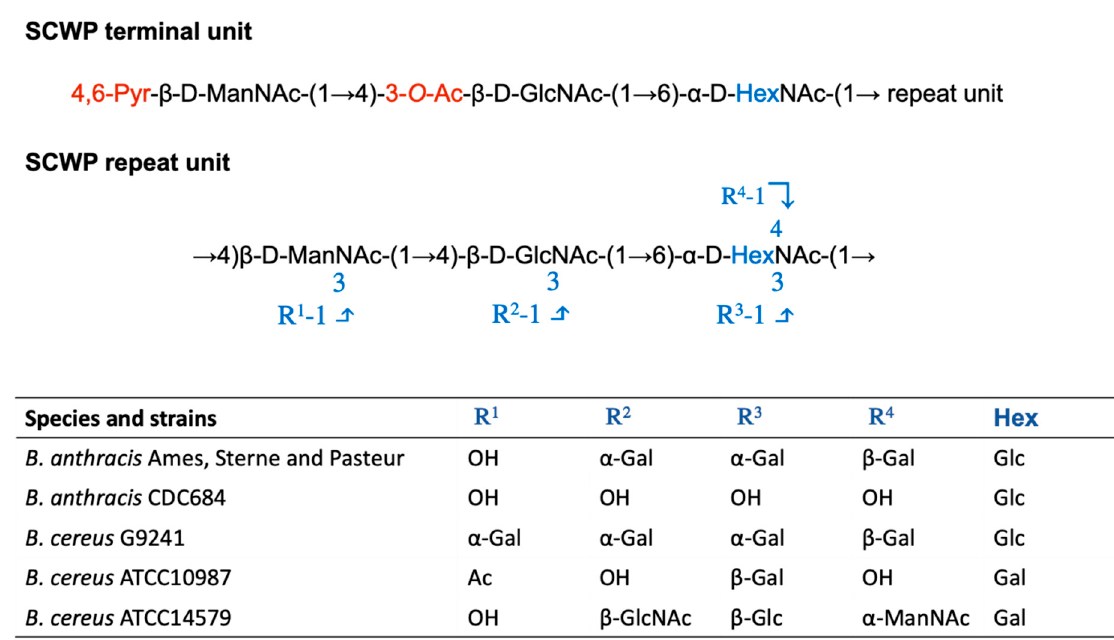
Figure 2. Structural variation of the SCWP trisaccharide units amongst various members of the Bacillus cereus group. Structure of the terminal and the repeat units of B. cereus sensu lato SCWP. In black is the common trisaccharide backbone, in blue the variation as indicated in the table for B. anthracis , B. cereus G9241, B. cereus ATCC 10987, and B. cereus ATCC 14579.